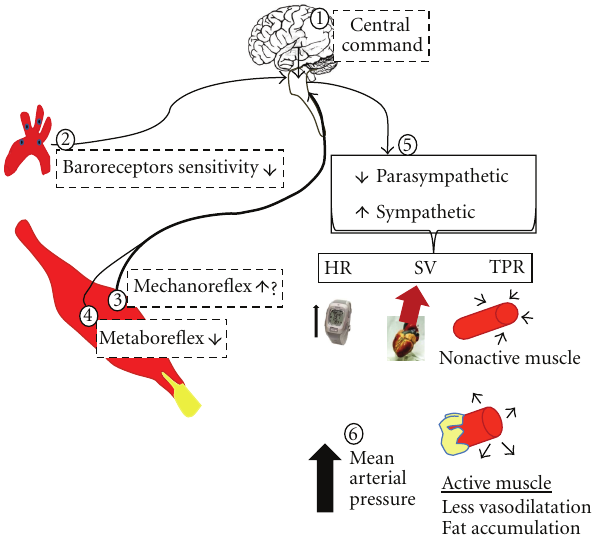
Figure 2: Alterations in the control of blood pressure during exercise in obese individuals: the baroreflex is less sensitive to stimulation (i.e., exercise) and the metaboreflex is blunted. Mechan- ically sensitive a ff erent neurons may therefore undergo functional changes to compensate for the reduced metaboreflex. These alter- ations may promote chronic adjustments in peripheral vascular resistance, precipitate fatigue during exercise and delay vasodilata- tion during exercise recovery. HR: Heart Rate; SV: Stroke Volume; TPR: Total Peripheral